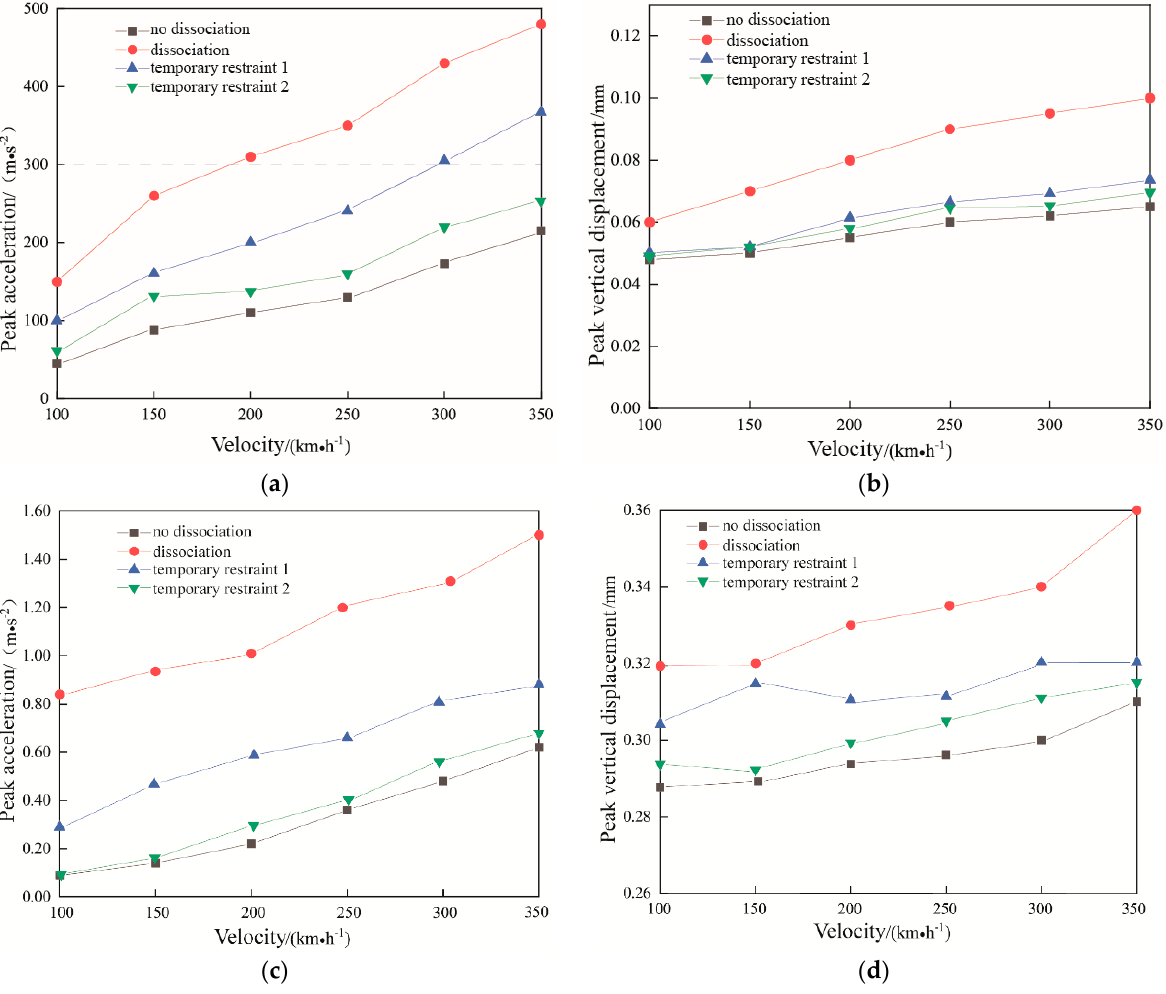
Figure 21. Peak acceleration and displacement curves at different train speeds. ( a ) the peak acceleration curve, and ( b ) peak displacement curve at the center of the track slab in the middle of the mode; ( c ) peak acceleration curve, and ( d ) peak displacement curve at the corresponding position of the subgrade bed.